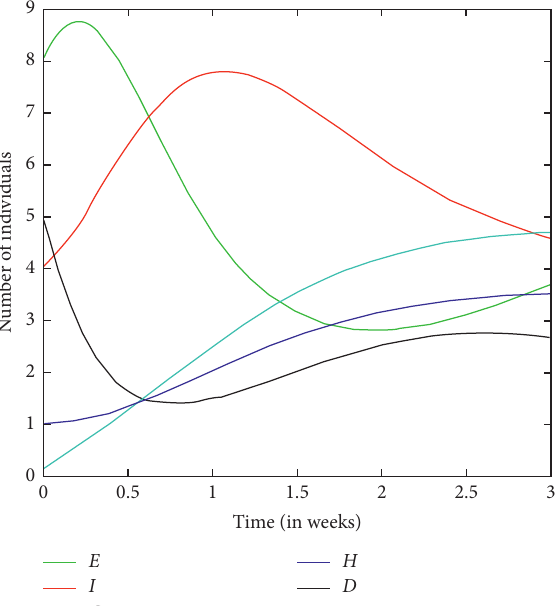
Figure 3: Variations in all